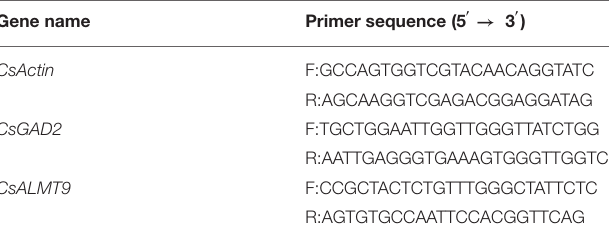
TABLE 2 | Primers used for gene expression